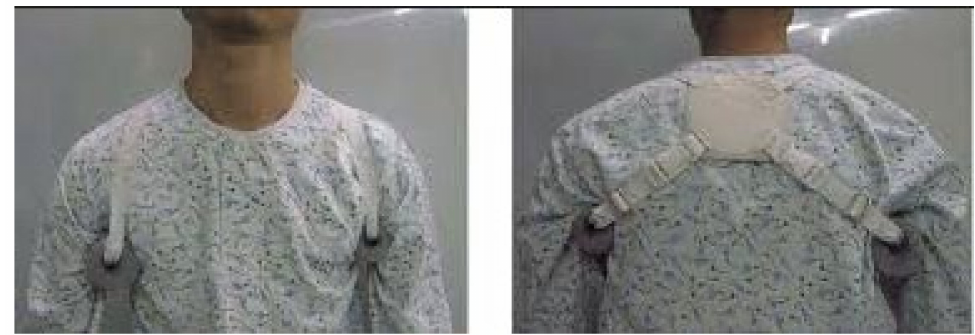
Figure 2. Bobath